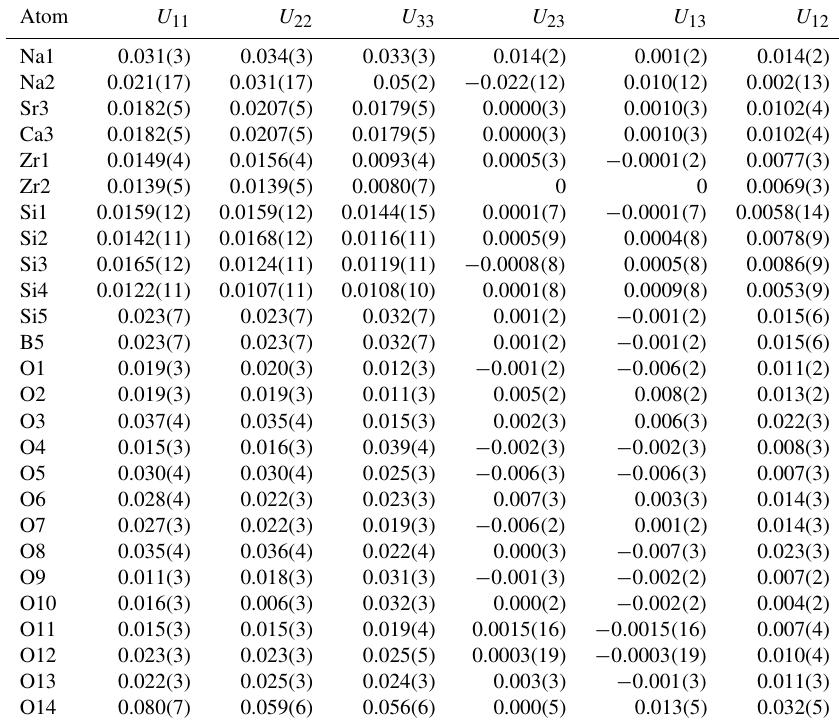
Table 4. Anisotropic displacement parameters (in Å 2 ) for